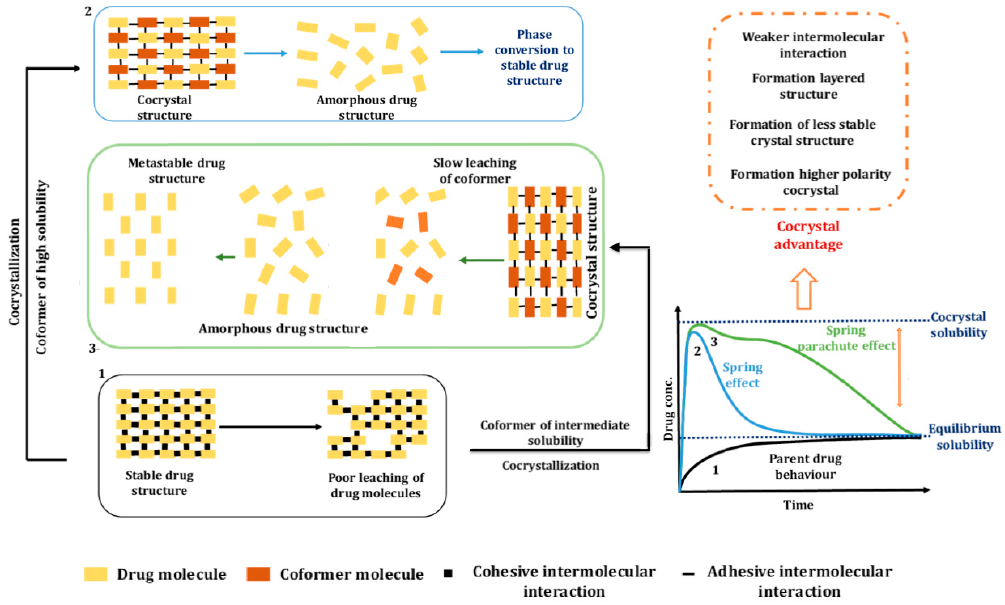
Figure 7. Illustration of the influence of coformer solubility on the spring and parachute effect of cocrystals. Table 1. Examples of studies reported on the effects of coformers on the solubility, dissolution rate, and bioavailability of drug molecules in cocrystals.